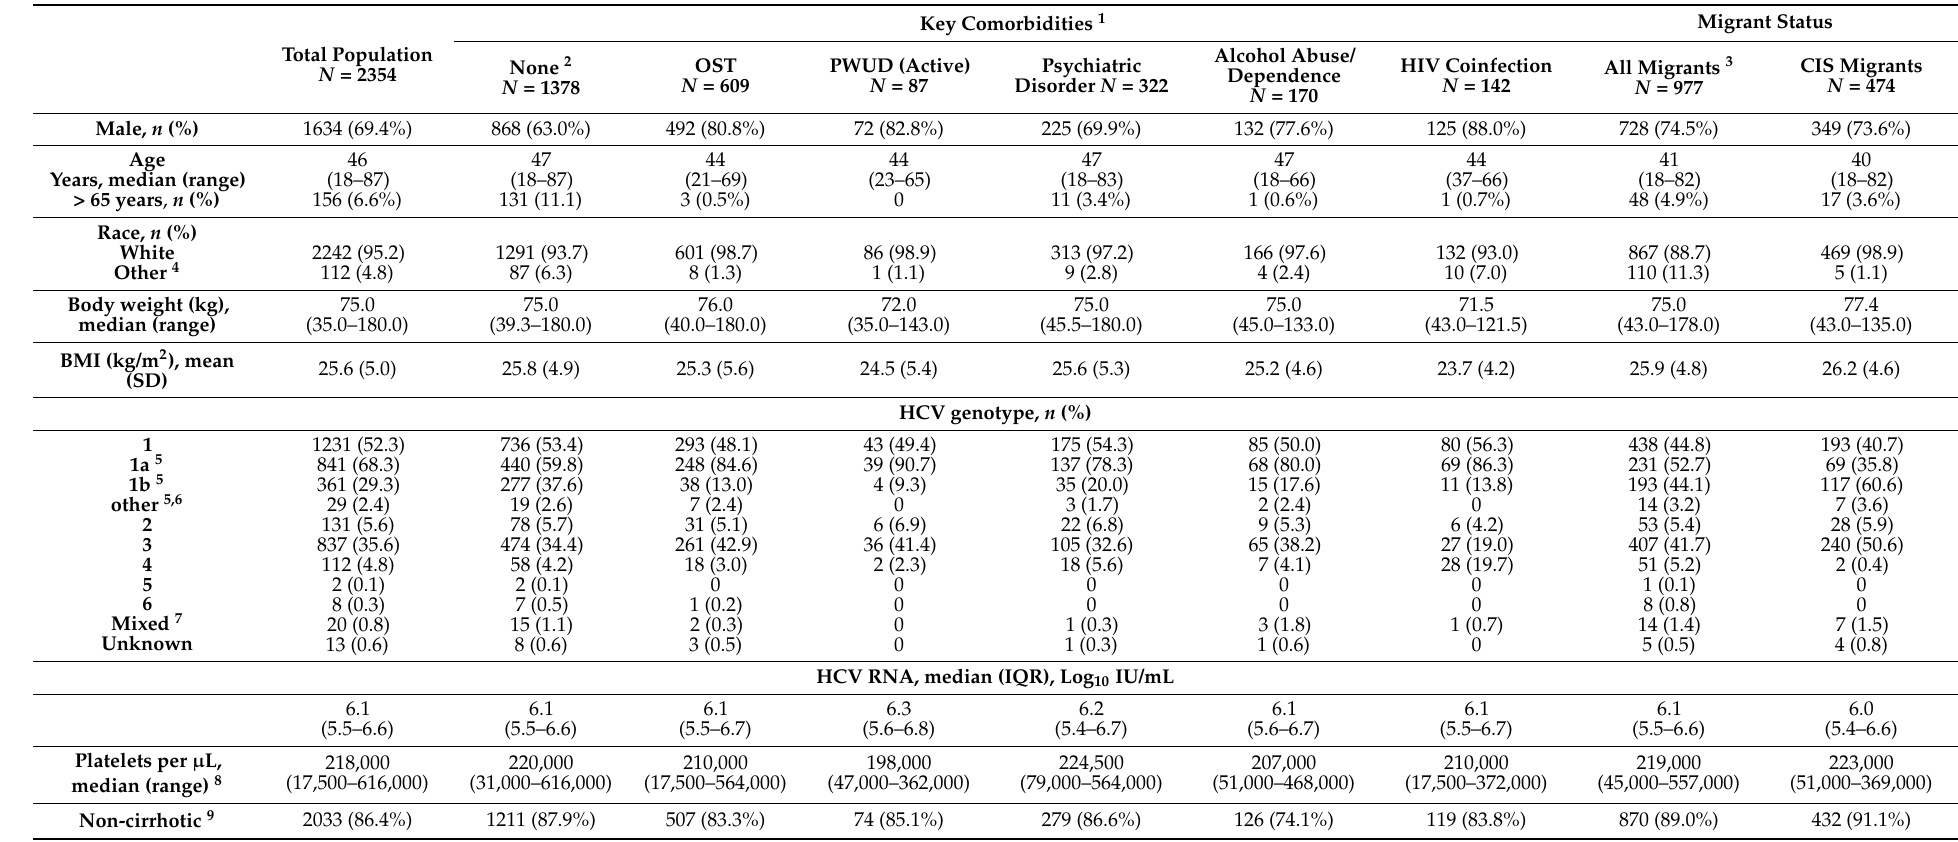
Table 1. Demographics and clinical characteristics at baseline (total on-label